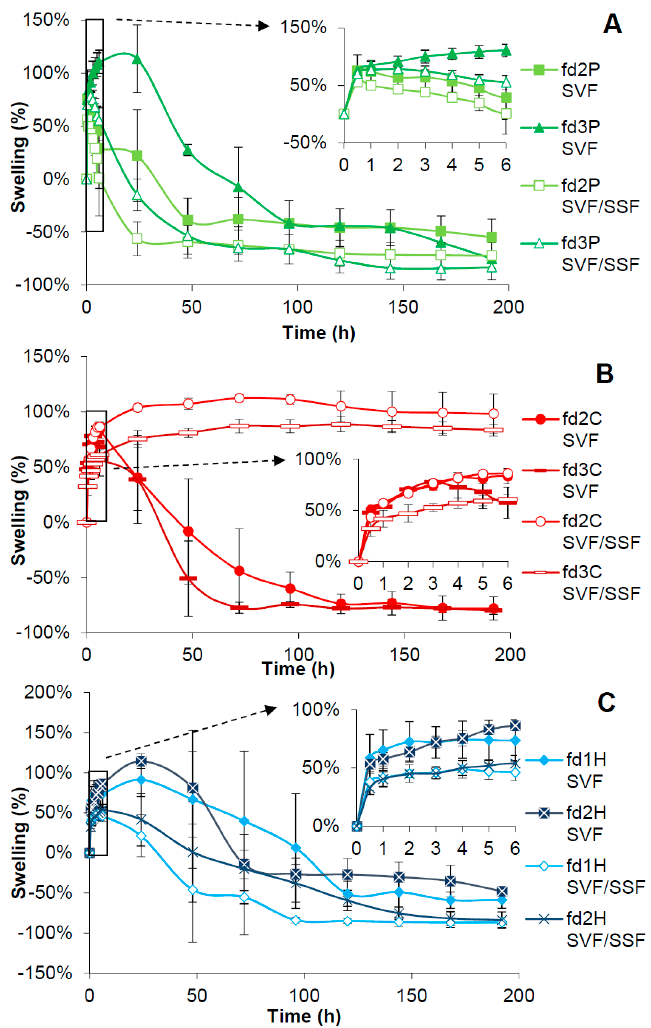
Figure 5. Swelling profiles obtained from tests in simulated vaginal fluid (SVF) and SVF/simulated seminal fluid (SSF) mixture for freeze-dried bigels containing pectin ( A ), chitosan ( B ), and HPMC ( C ). In each graph the first 6 h of test are amplified at the top right.